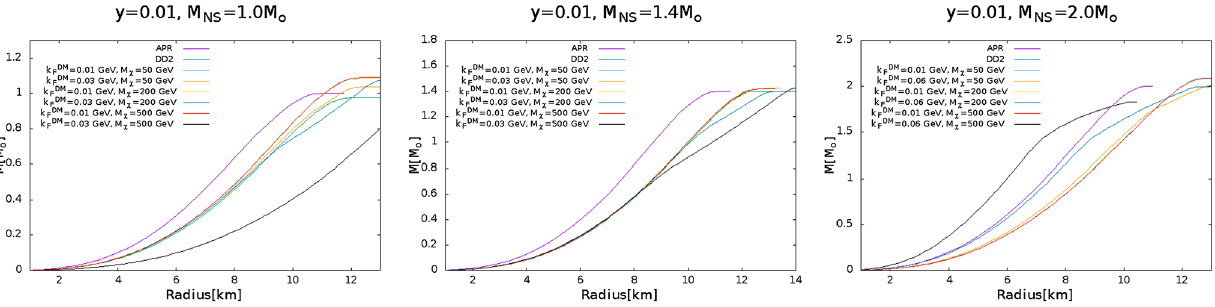
Fig. 2 Enclosed mass vs radius plots for M NS = 1 . 0 M (cid:8) (left panel), M NS = 1 . 4 M (cid:8) (middle panel), M NS = 2 . 0 M (cid:8) (right panel) with varying DM mass and Fermi momentum in each panel